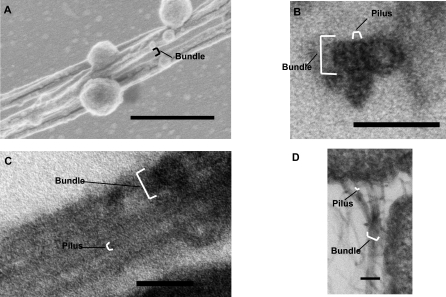
Structure of Tfp Bundles(A) SEM picture of a collection of bundles in a polylysine-treated sample. Scale bar = 500 nm.(B) Thin-section microscopy image of the cross-section of a collection of bundles in a polylysine-treated sample (here composed of two bundles). Scale bar = 50 nm.(C) Thin-section microscopy image of the long axis of a collection of bundles in a polylysine-treated sample (here composed of three bundles). Scale bar = 50 nm.(D) Thin-section microscopy image of a bundle attached to a bacterium in a sample incubated with DMEM only. Scale bar = 50 nm.